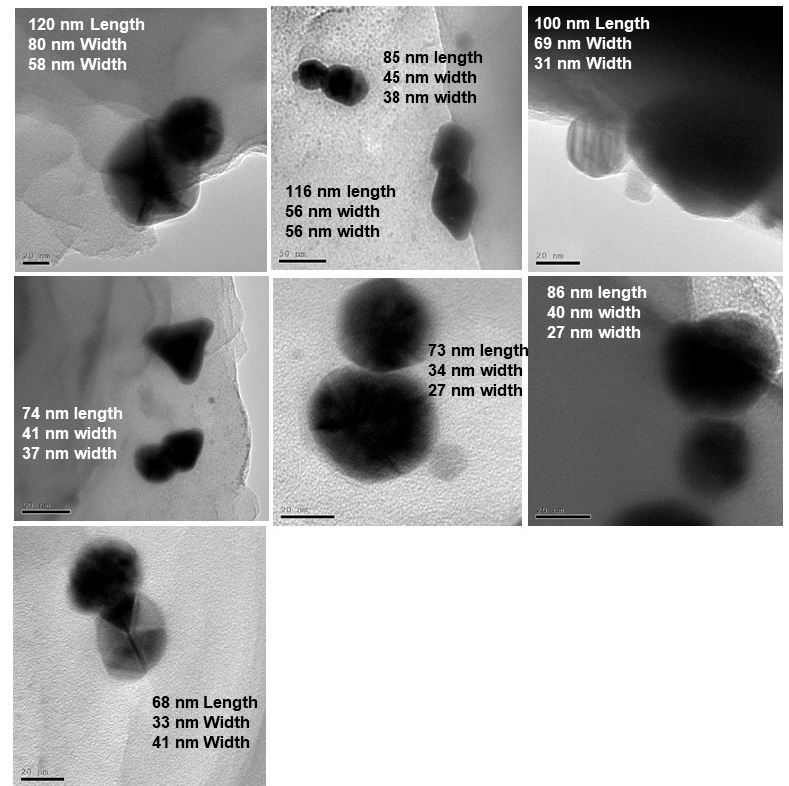
Figure 6. Bright field TEM images showing large Au-Ag nanotwins formed by 120 min of irradiation of large, anisotropic AuNPs seeds followed with 30 min of irradiation with Ag + feed.